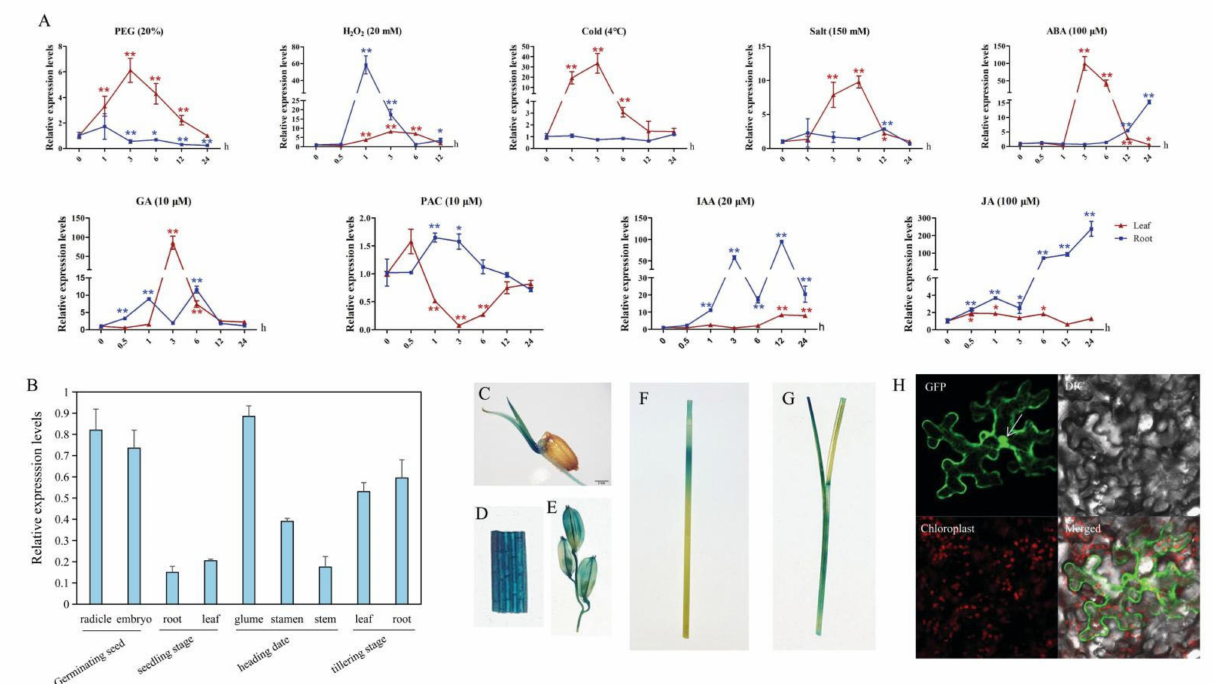
Figure 2. Expression profile of OsGA2ox8. ( A ) Expression changes in OsGA2ox8 in shoots and roots under different treatments analyzed by qRT-PCR. ( B ) Expression levels of OsGA2ox8 in different tissues at various developmental stages analyzed by qRT-PCR. C–G Histochemical assay of GUS activity driven by the OsGA2ox8 promoter in the leaves and roots 3 days after germination ( C ), leaf blade ( D ), glume ( E ), stem ( F ), and shoots at the two-leaf stage ( G ). ( H ) Subcellular localization of OsGA2ox8 in tobacco leaves. Error bars indicate the SD based on three replicates. Asterisks indicate a significant difference compared with 0 h treatment (* p < 0.05, ** p < 0.01; Student’s t